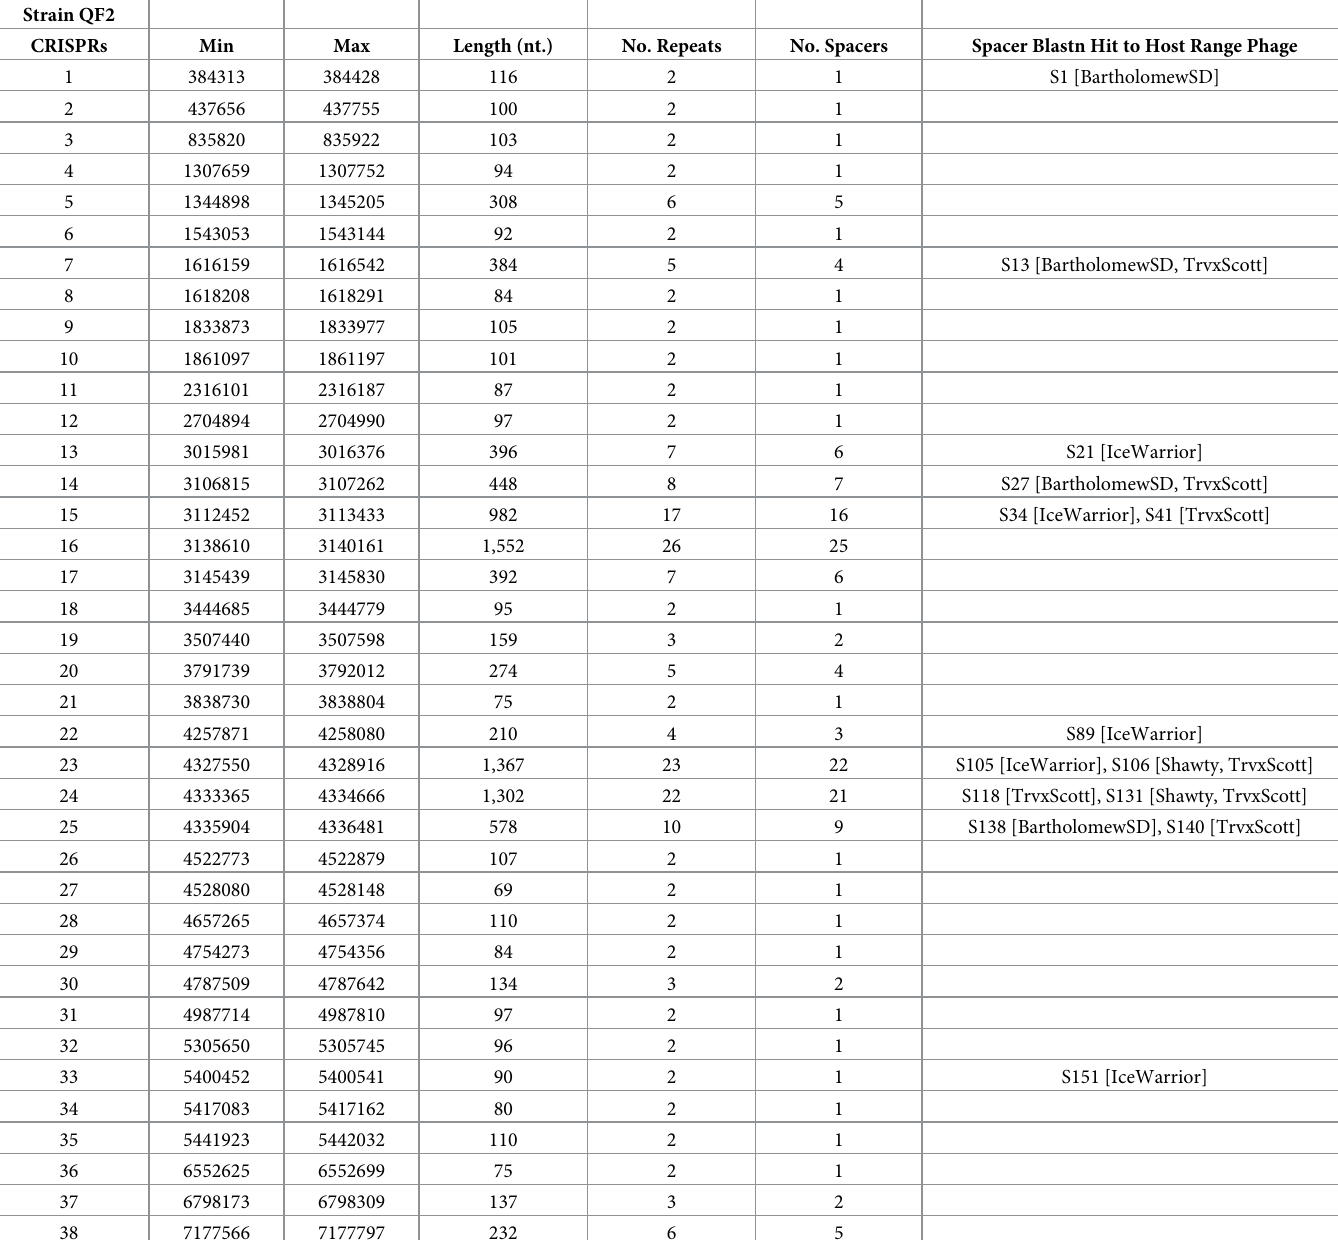
Table 10. Characteristics of the 38 CRISPRs predicted in the draft genome sequence of strain